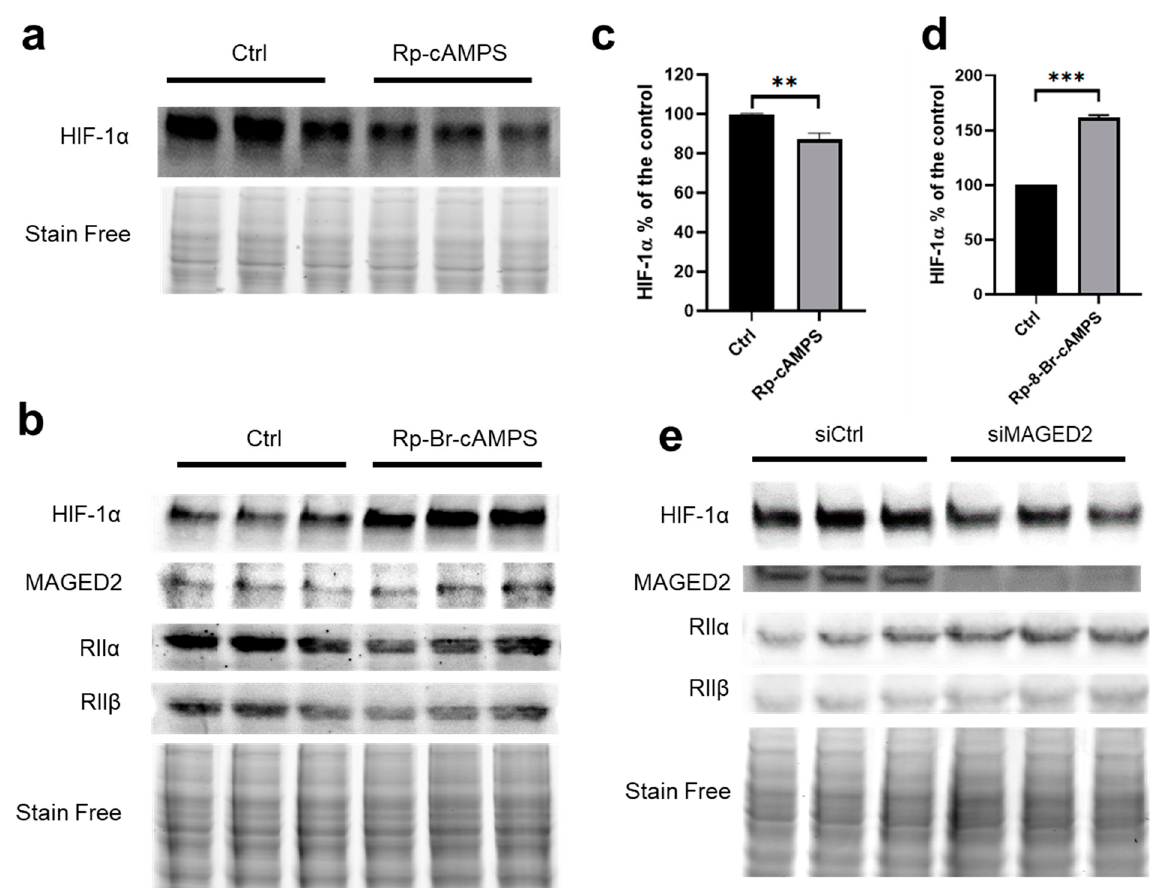
Figure 5. PKA type II regulates HIF-1 α protein abundance: ( a , b ) HEK293 cells were treated with the non-selective PKA inhibitor (Rp-cAMPS, 100 µM) or the selective PKA type I inhibitor (Rp-8-Br- cAMPS, 50µM) for 30 min under CoCl 2 . Total cell lysates were separated by SDS-PAGE and probed with anti-HIF-1 α , MAGED2, RII α , or RII β antibodies. ( c , d ) Densitometric analysis of HIF-1 α im- munoblot presented in ( a , b ), respectively. ( e ) cells were transfected with control (siCtrl) or MAGED2 (siMAGED2) siRNA. Cells were exposed to 300 µM CoCl 2 for 14–16 h. Total cell lysates were sepa- rated by SDS-PAGE and probed with anti-HIF-1 α , MAGED2, RII α , and RII β antibodies. Statistical significance was determined by unpaired two-sided Student’s t -test ( c , d ). All Western blots shown are from the same experiment, which is a representative example of three independent experiments. Bar graphs show mean ± SEM. ** p ≤ 0.01 and *** p ≤ 0.001.